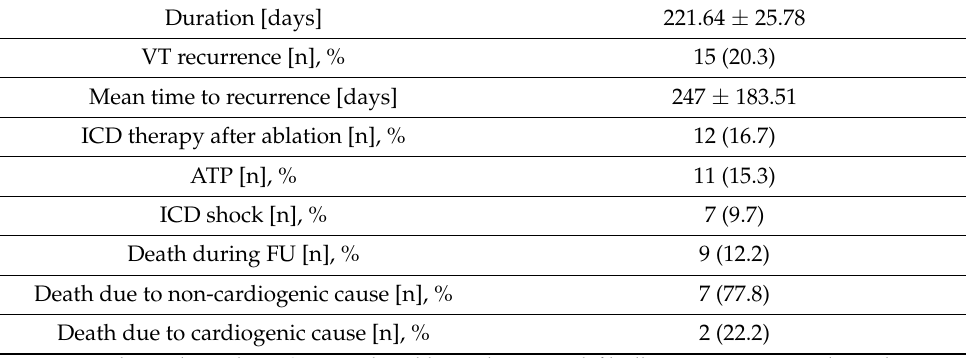
Table 3. Follow-up